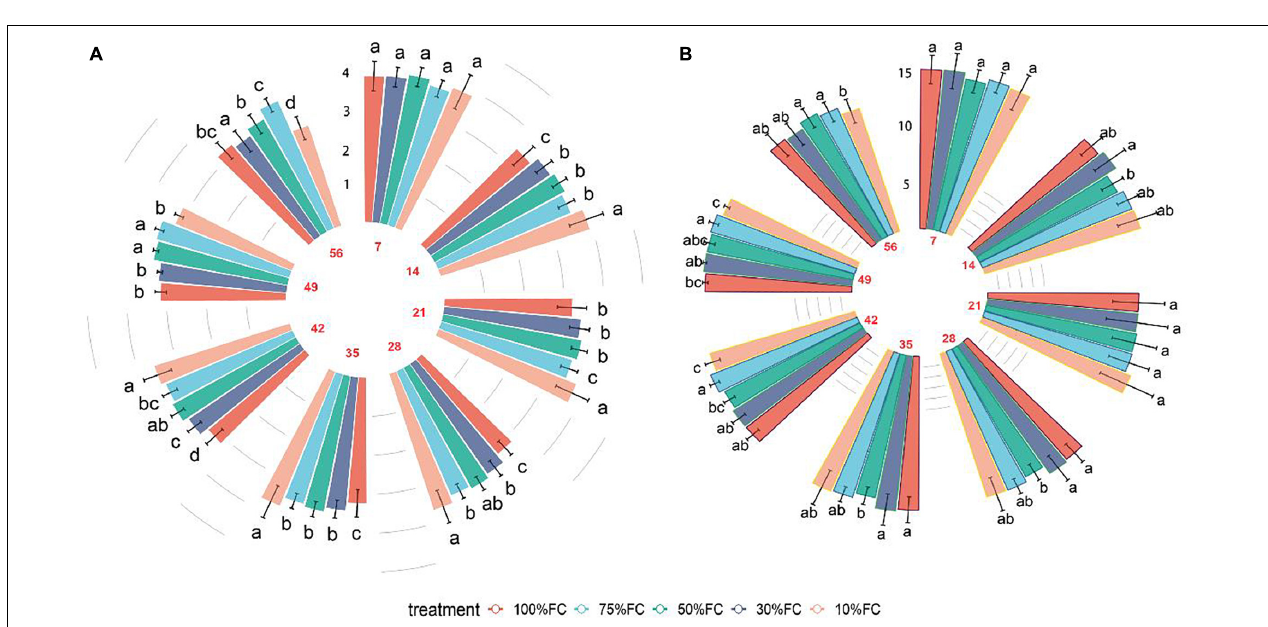
FIGURE 5 | One-way ANOVA was used to examine the discrepancies between separate drought stress treatments over time. (A) Chlorophyll, (B) nitrogen. Vertical bars indicate ± SE. Comparison between treatments at the same time different letter indicates statistically significant differences according to Tukey’s HSD test. Values sharing a common letter are not significantly different at p < 0.01. Red numbers indicate the duration of drought stress.